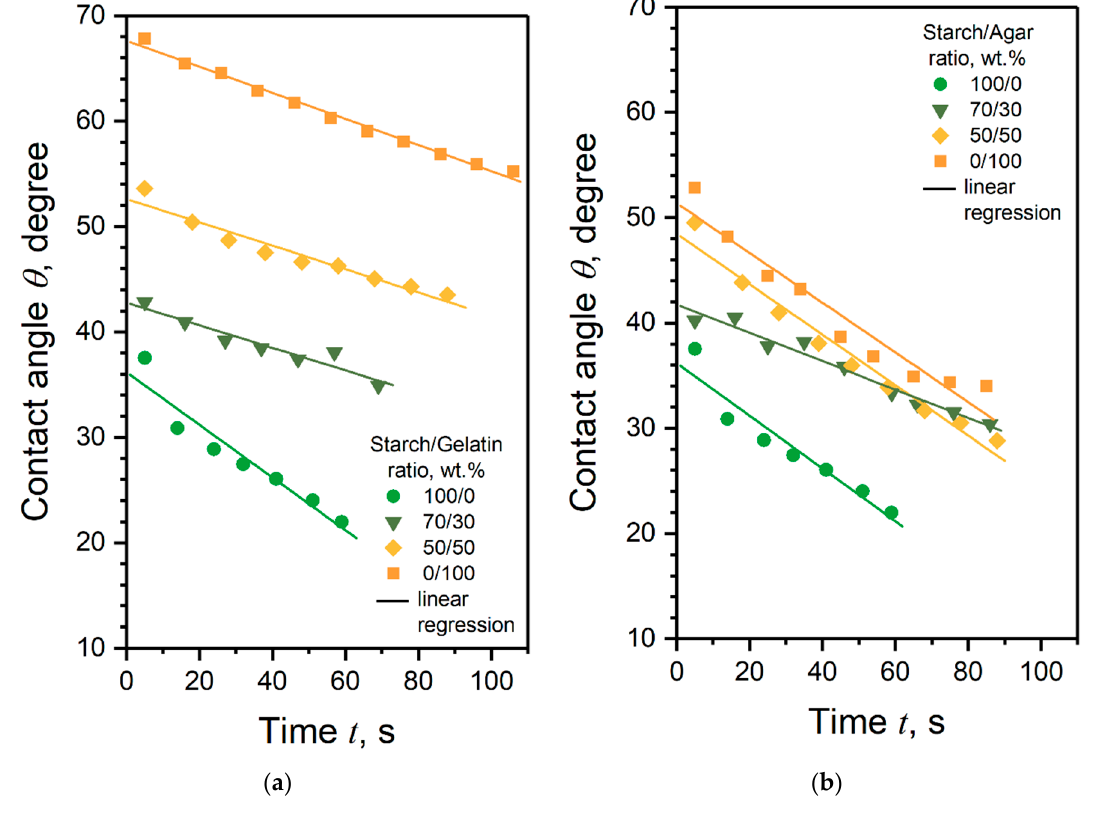
Figure 7. Time dependencies of the water contact angle values of the coatings based on ( a ) potato starch, gelatin and their blends and ( b ) potato starch, agar and their blends.